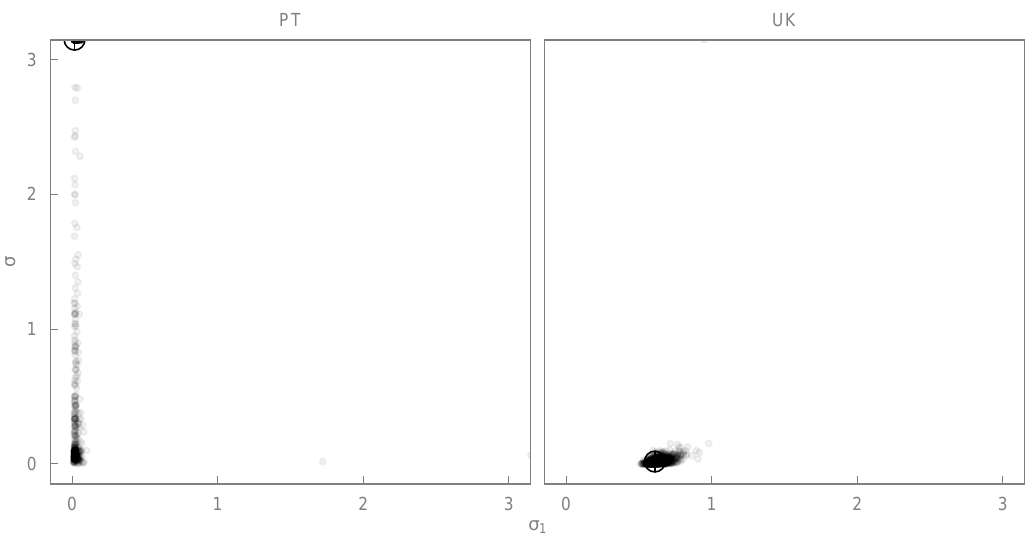
Figure 9. Bootstrap resampling distribution for ˆ α k , ˆ α l , and ˆ α e for resampled CES models that reject the CSP, include energy, use quality-adjusted factors of production, and employ the ( kl ) e nesting structure. Output elasticity estimates from the original data are shown as thick lines. Output elasticities from 1000 resamples are shown as lines with 95% transparency such that twenty coincident lines will appear black. Compare to the middle row of Figure 6.